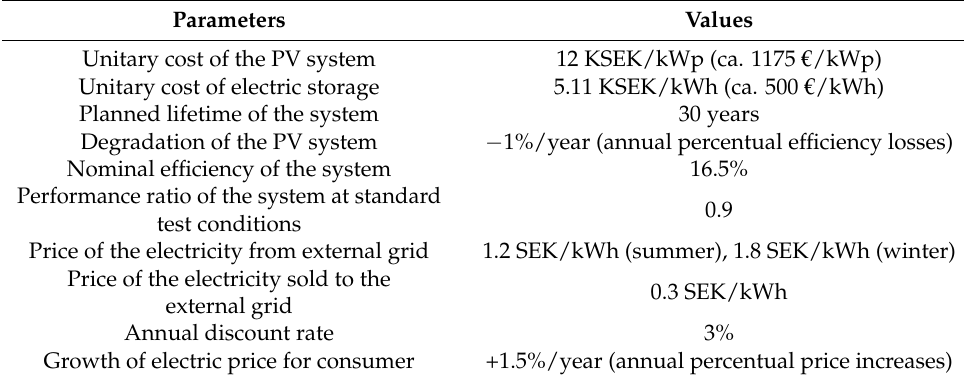
Table 4. Assumption used in the optimization of the PV